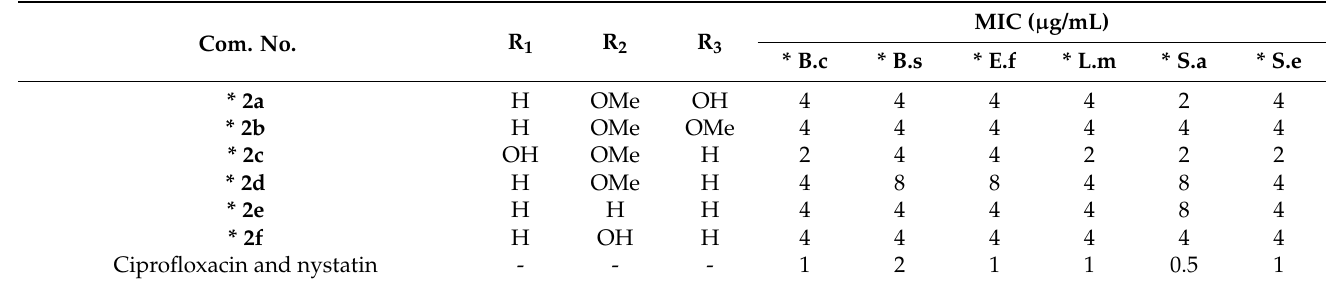
Table 2. Isolated compounds from Paulownia tomentosa were showed to display potent antibacterial activity against several Gram-positive strains.